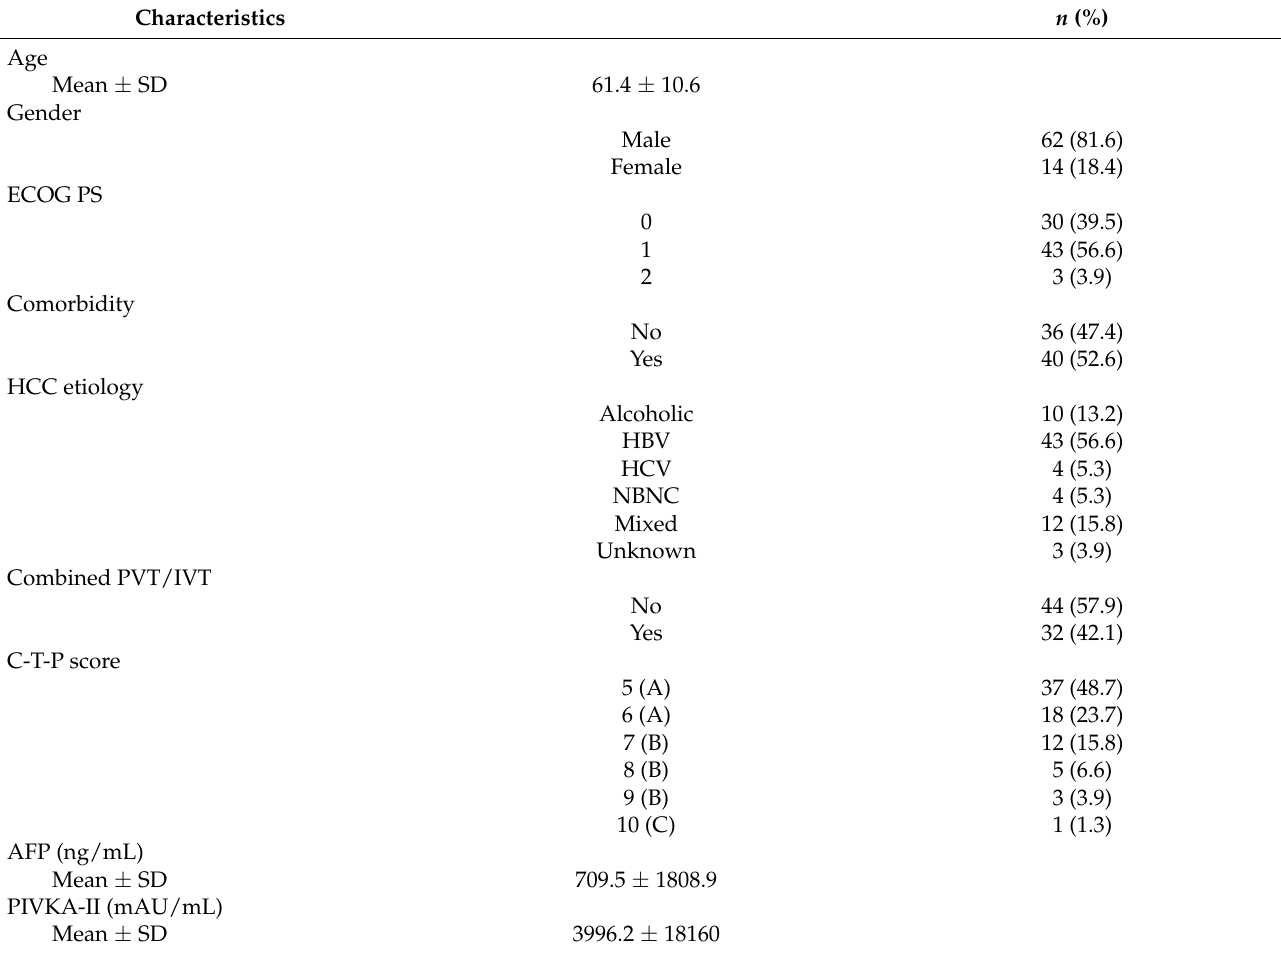
Table 1. Baseline patient and tumor